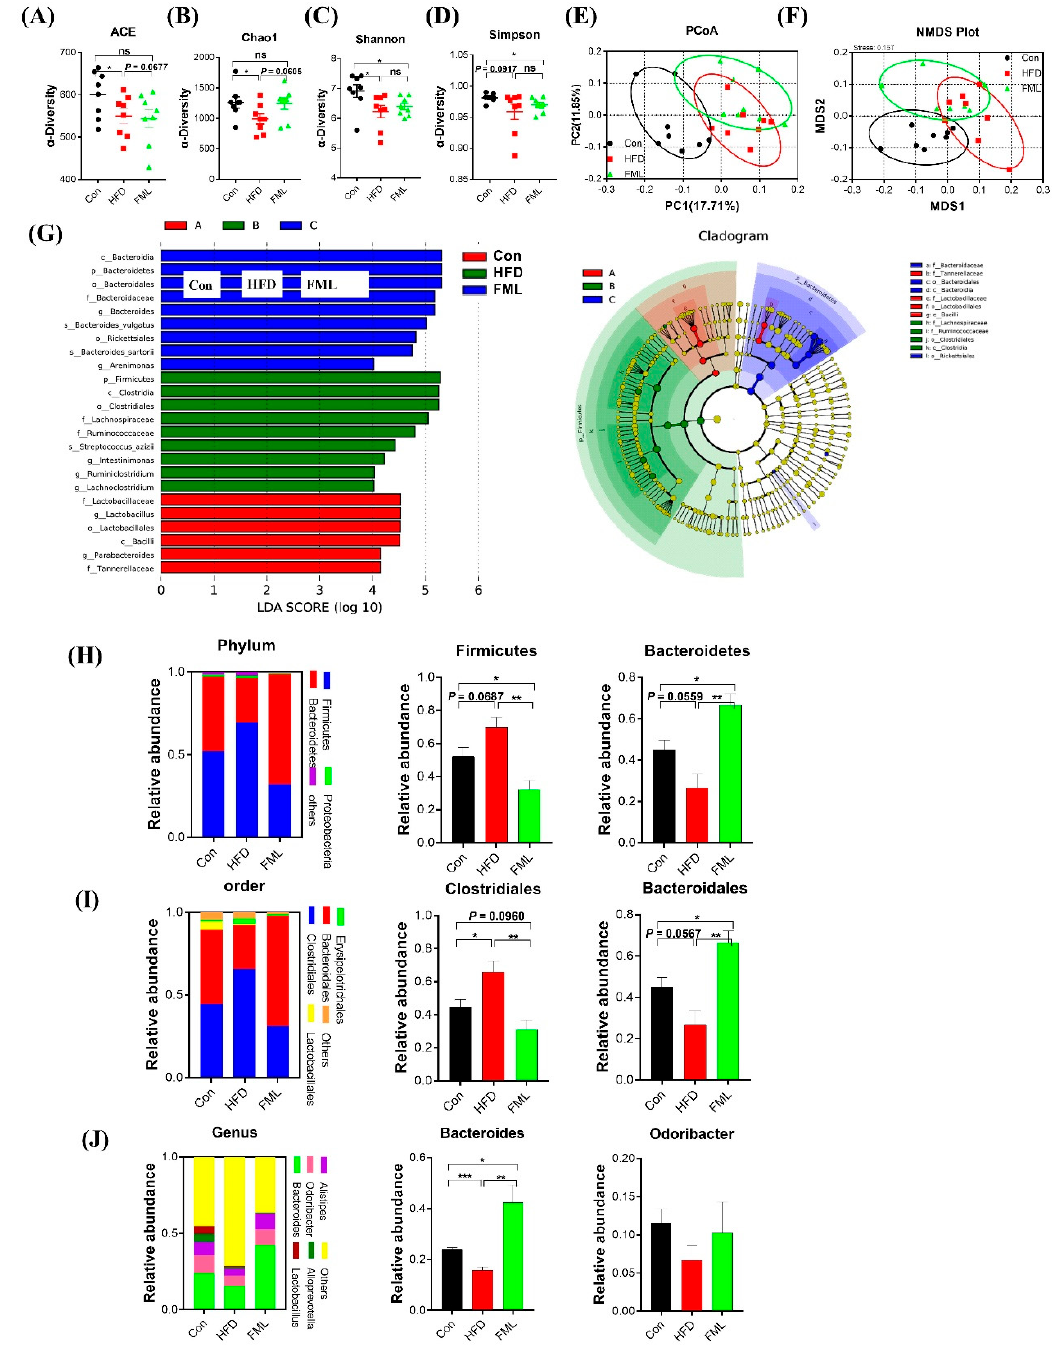
Figure 5. FML administration improved gut microbiota in HFD-fed mice ( n = 8). ( A – D ) Indexes of ACE, Chao1, Shannon, and Simpson in α -diversity analysis, ( E ) Principal Coordinate Analysis (PCoA) plot analysis from each sample, ( F ) NMDS plot analysis from each sample, ( G ) LEfSe cladogram represents differentially abundant taxa. Only taxa with LDA scores of more than 2 are presented, ( H ) microbiota compositions at the phylum level, ( I ) microbiota compositions at the order level, ( J ) microbiota compositions at the genus level. Data are presented as mean ± SEM, differences were denoted as follows: * p < 0.05, ** p < 0.01, *** p < 0.001; ns p > 0.05.